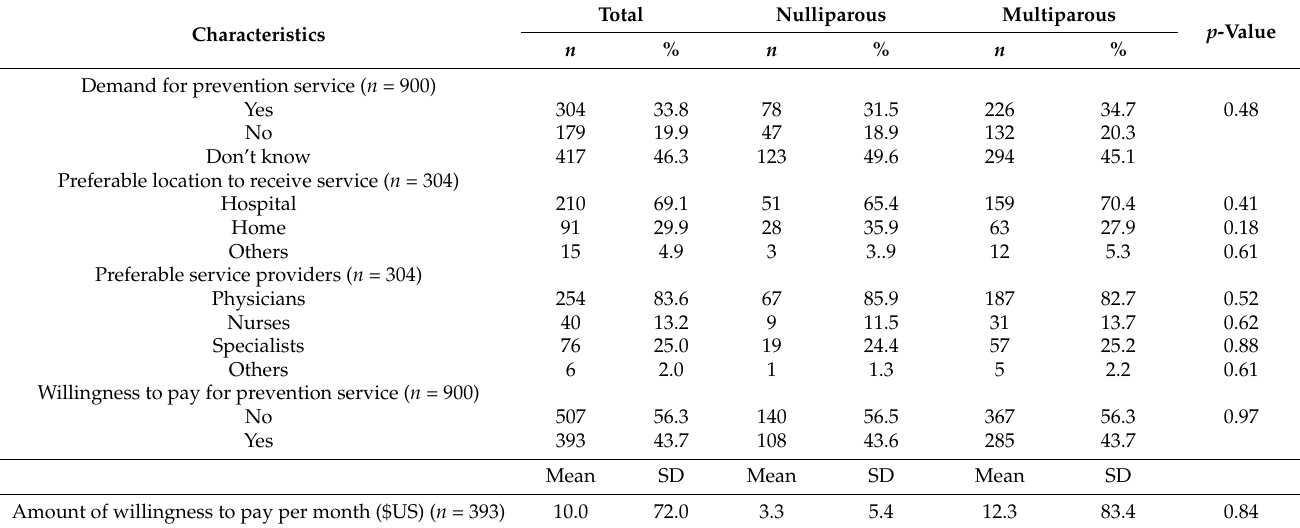
Table 4. Preferences for fear of childbirth prevention